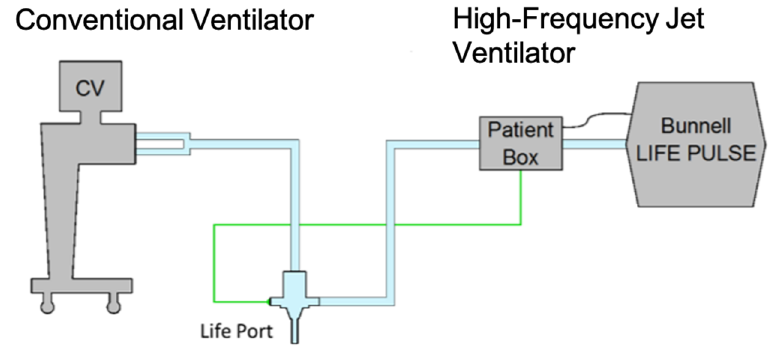
Figure 3. Arrangement of ventilators in the experiment. The connection of the ventilation circuits is realized by means of the Life Port fitting.